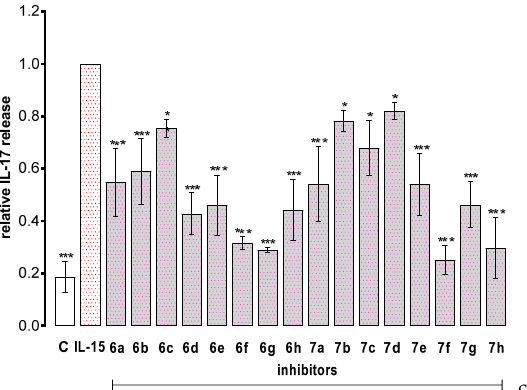
Figure 4. The effect of the tested compounds on IL–15–triggered PBMC response: proliferation ( a ), TNF– α release ( b ) and IL–17 release ( c ). Results are expressed as mean ± SEM of three experiments. Data were analyzed by one way analyses of variance (ANOVA) followed by the post hoc Dunnett test. * p < 0.05, ** p < 0.01, *** p < 0.001 vs. IL–15.